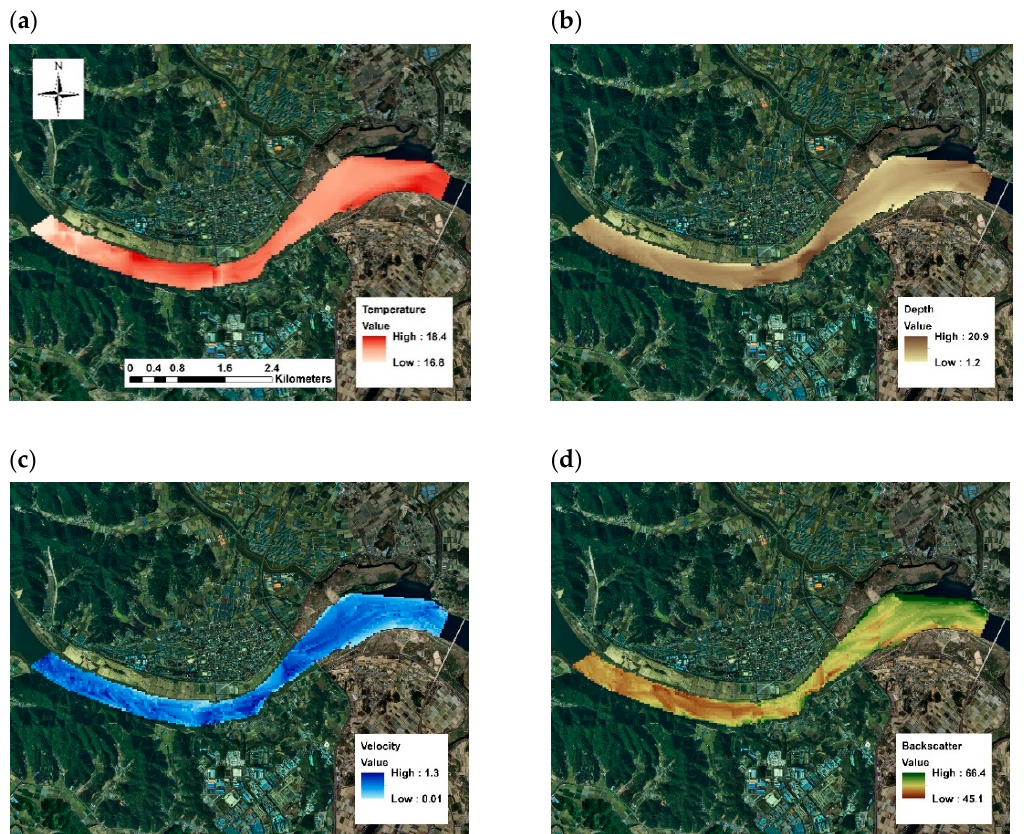
Figure 4. Hydro-morphodynamic parameters collected by the ADCP: ( a ) water surface temperature, ( b ) bathymetry, ( c ) depth-averaged velocity, and ( d ) backscatter.